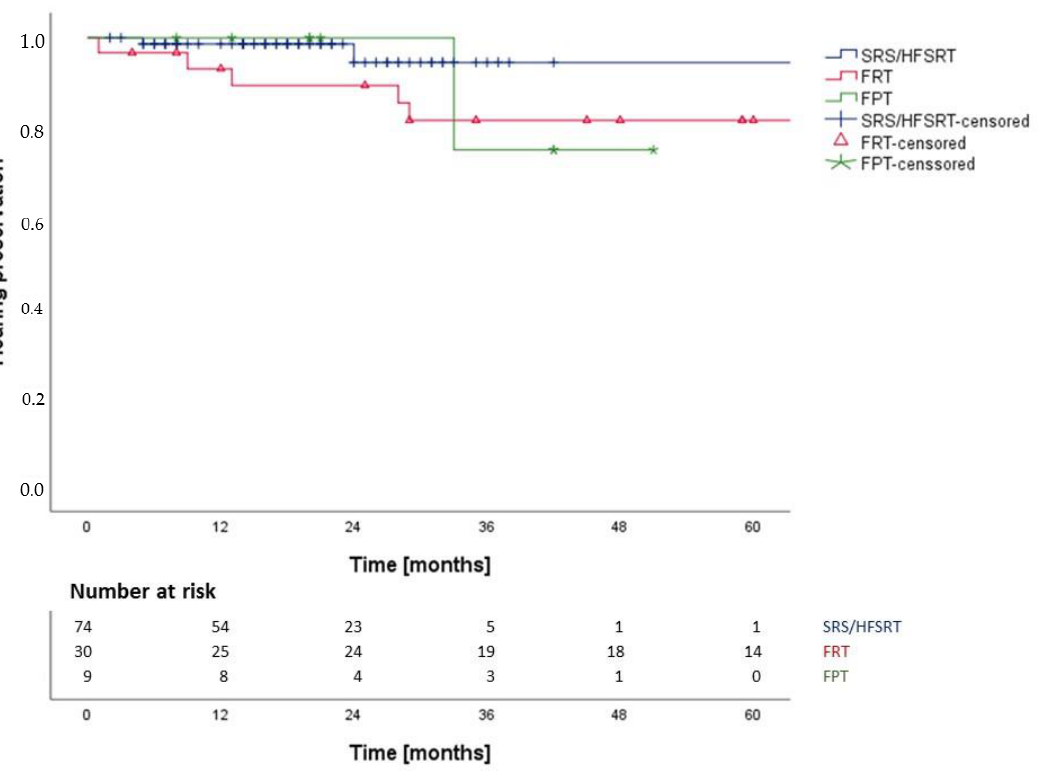
Figure 4. Hearing preservation after SRS/HFSRT vs. FRT vs. FPT ( p = 0.31); SRS-HFSRT/FRT (HR: 0.3, 95%-CI: 0.1 – 1.4), SRS-HFSRT/FPT (HR: 0.4, 95%-CI: 0.0 – 5.3) and FRT/FPT (HR: 1.2, 95%-CI: 0.1 –